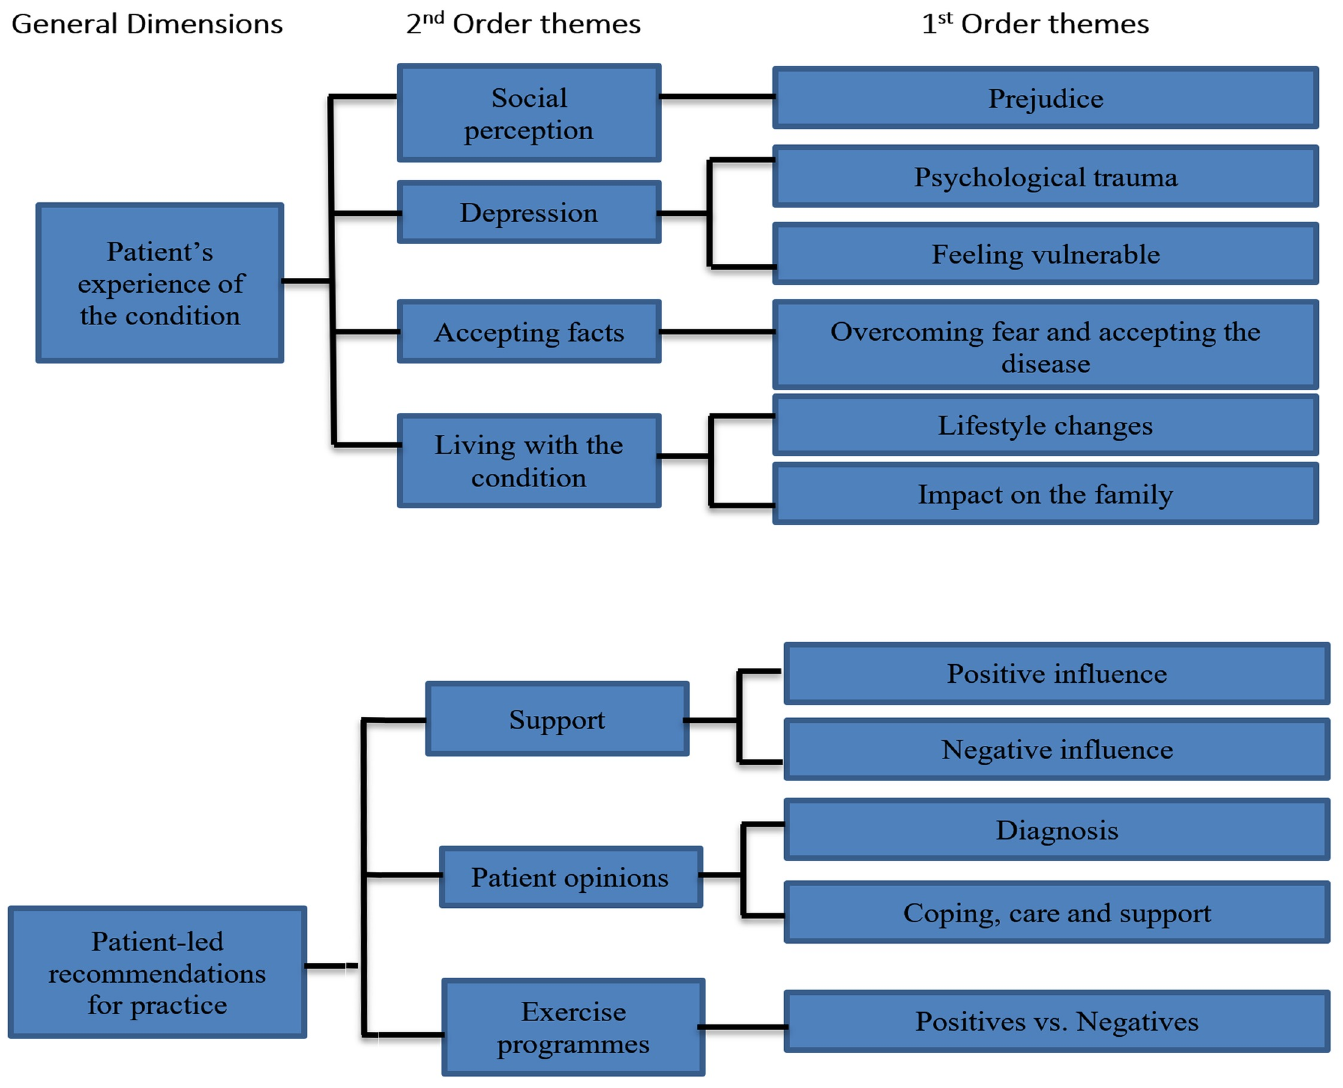
Fig 1. Key themes representing patients’ experiences of IPF and patient-led recommendations for